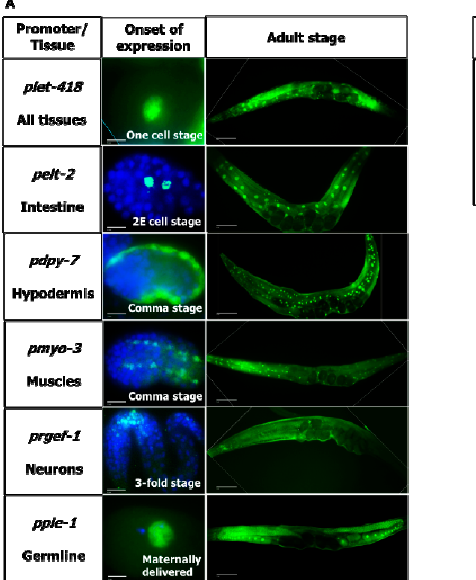
Figure 1. Tissue-specific expression of let-418 . ( A ) let-418 expression under the indicated promoter in the embryo and in the adult. ( B ) let-418 expression under the control of the hlh-8 promoter. DAPI in blue, antibody anti-FLAG in green. Scale bar embryo and adult 20 µ m.